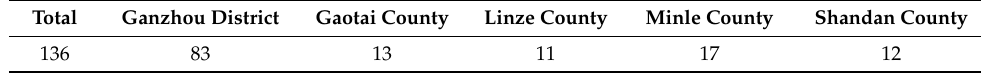
Table 2. The number of questionnaires in each county/district.